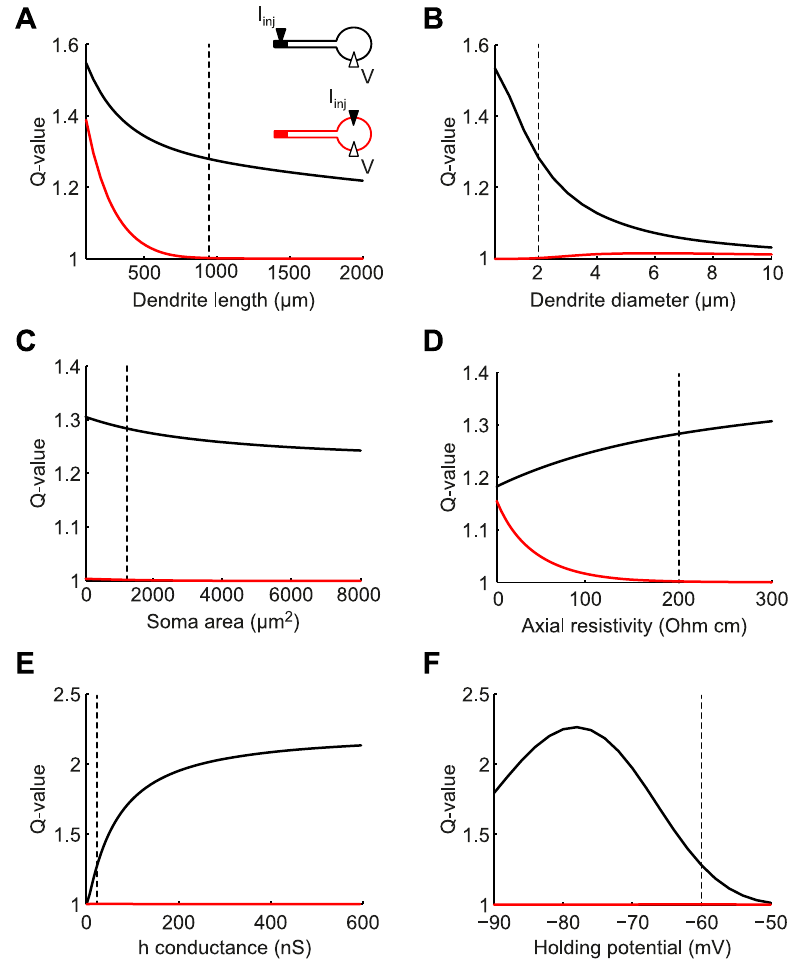
Figure 3. Dendritic resonance can be reflected somatically despite low-pass filtering of somatic inputs. Q-values of somatic input impedance (red curves) and dendro-somatic transfer impedance (black curves) when varying dendrite length (A), dendrite diameter (B), soma surface area (C), axial resistivity (D), h-conductance (E), and membrane holding potential (F). Vertical dashed lines indicate the default parameter values used in this study. There were large regions in the parameter space where MPOs propagated to the soma, but resonance was not detectable somatically.